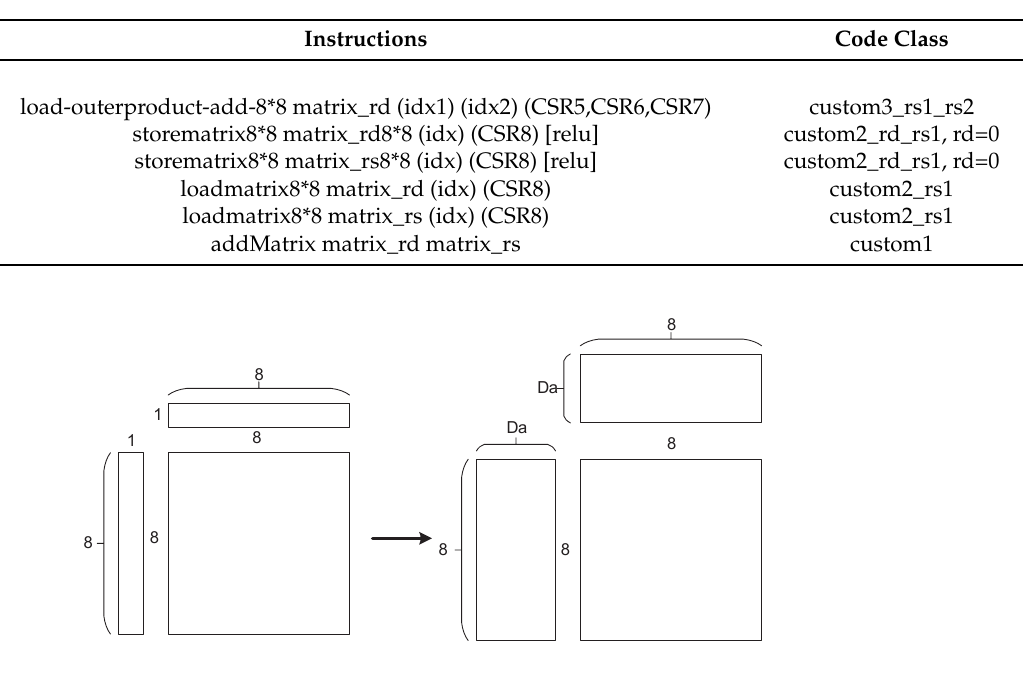
Table 4. The matrix instructions extension.